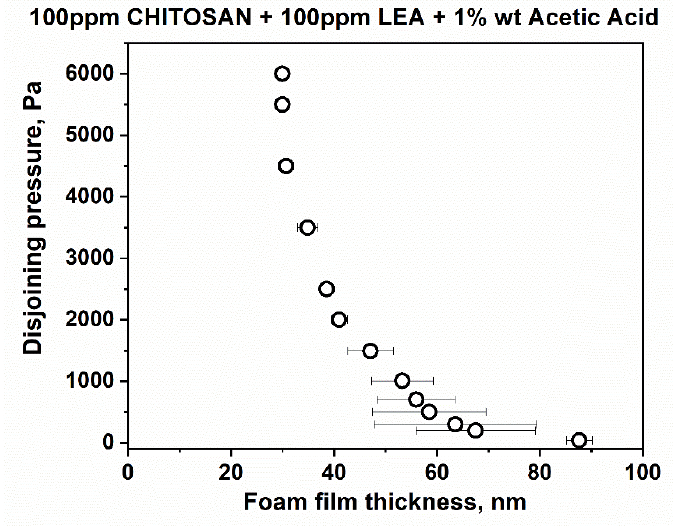
Figure 3. Disjoining pressure vs. film thickness isotherms of microscopic foam films, obtained using porous plate in TLF-PBT.